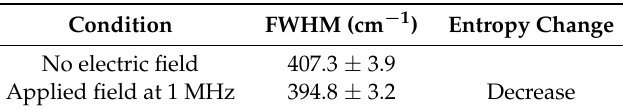
Table 2. Change in FWHMs of the band related to the ordering of internal water molecules in protein